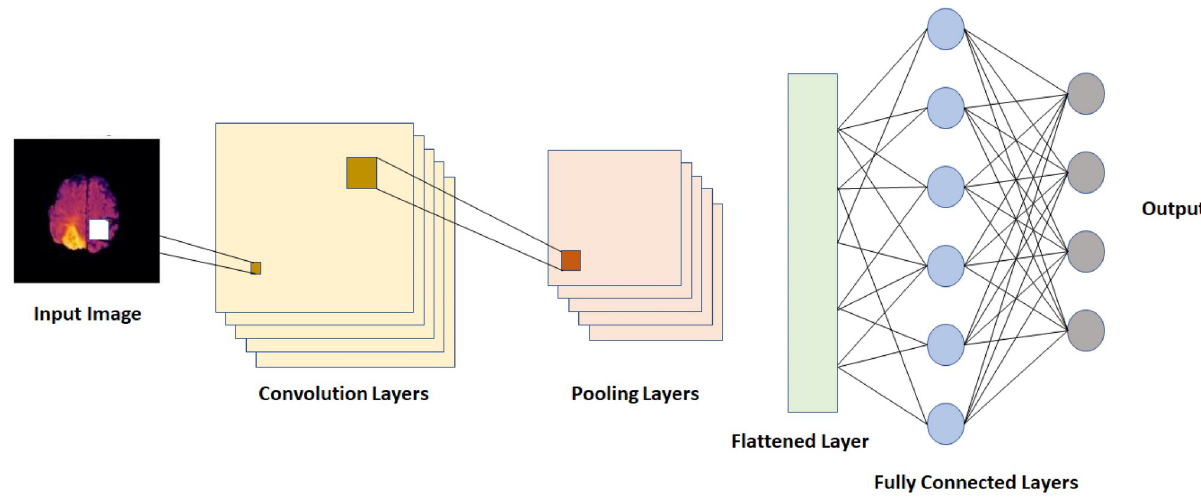
Fig 4. Basic CNN